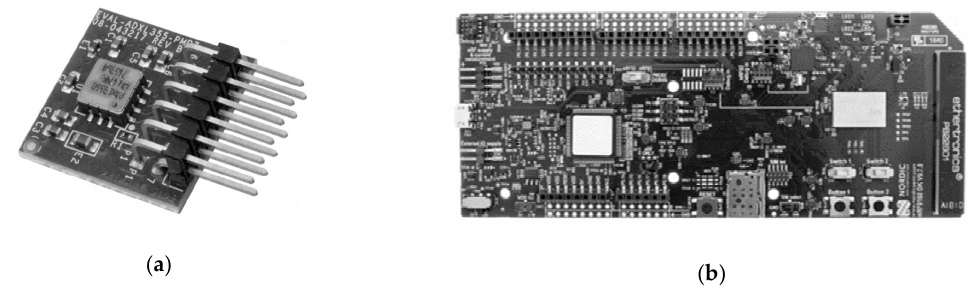
Figure 5. ( a ) ADXL 335 accelerometer; ( b ) Nordic Semiconductor nRF9160.